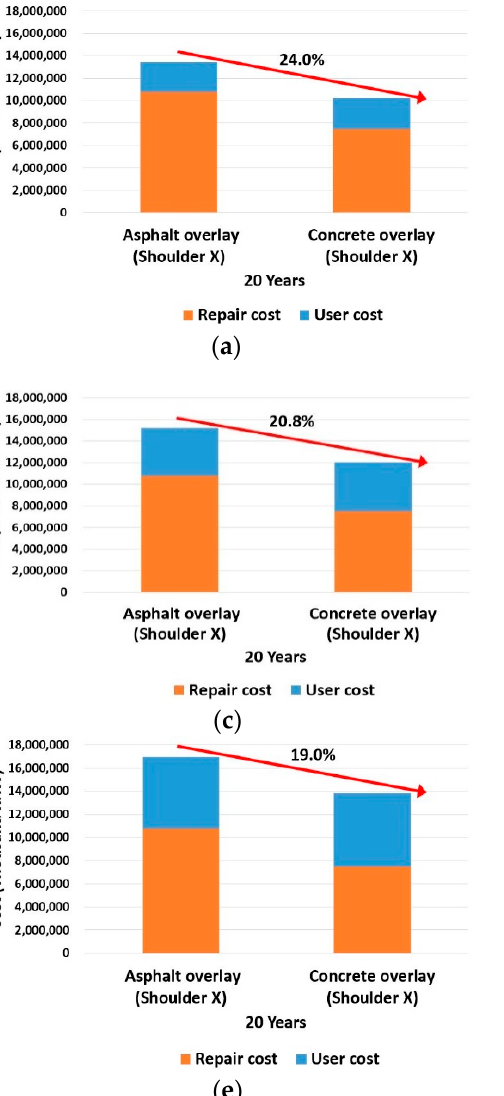
Figure 9. Economic analysis by 2-lane overlay method. ( a ) 2-lane 6000 AADT overlay economical (Shoulder X). ( b ) 2-lane 6000 AADT overlay economical (Shoulder O). ( c ) 2-lane 11,000 AADT over- lay economical (Shoulder X). ( d ) 2-lane 11,000 AADT overlay economical (shoulder O).